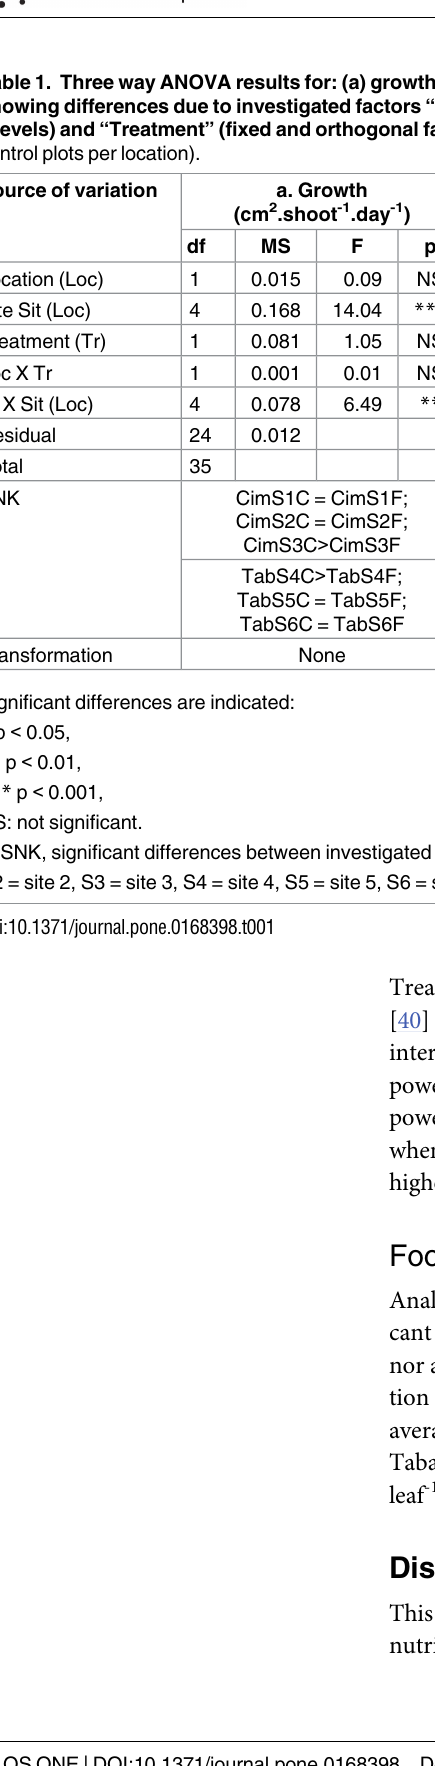
Analyses of the consumption recorded by food choice experiment did not detect any signifi- cant preference for fertilized vs. control shoots neither at CIMAR (Z = -0.730; p = 0.465; Fig 4) nor at Tabarca (Z = -1.153; p = 0.249; Fig 4). As found in the plots, overall values of consump- tion detected by tethers were low. Despite the fact that no significant differences were detected,